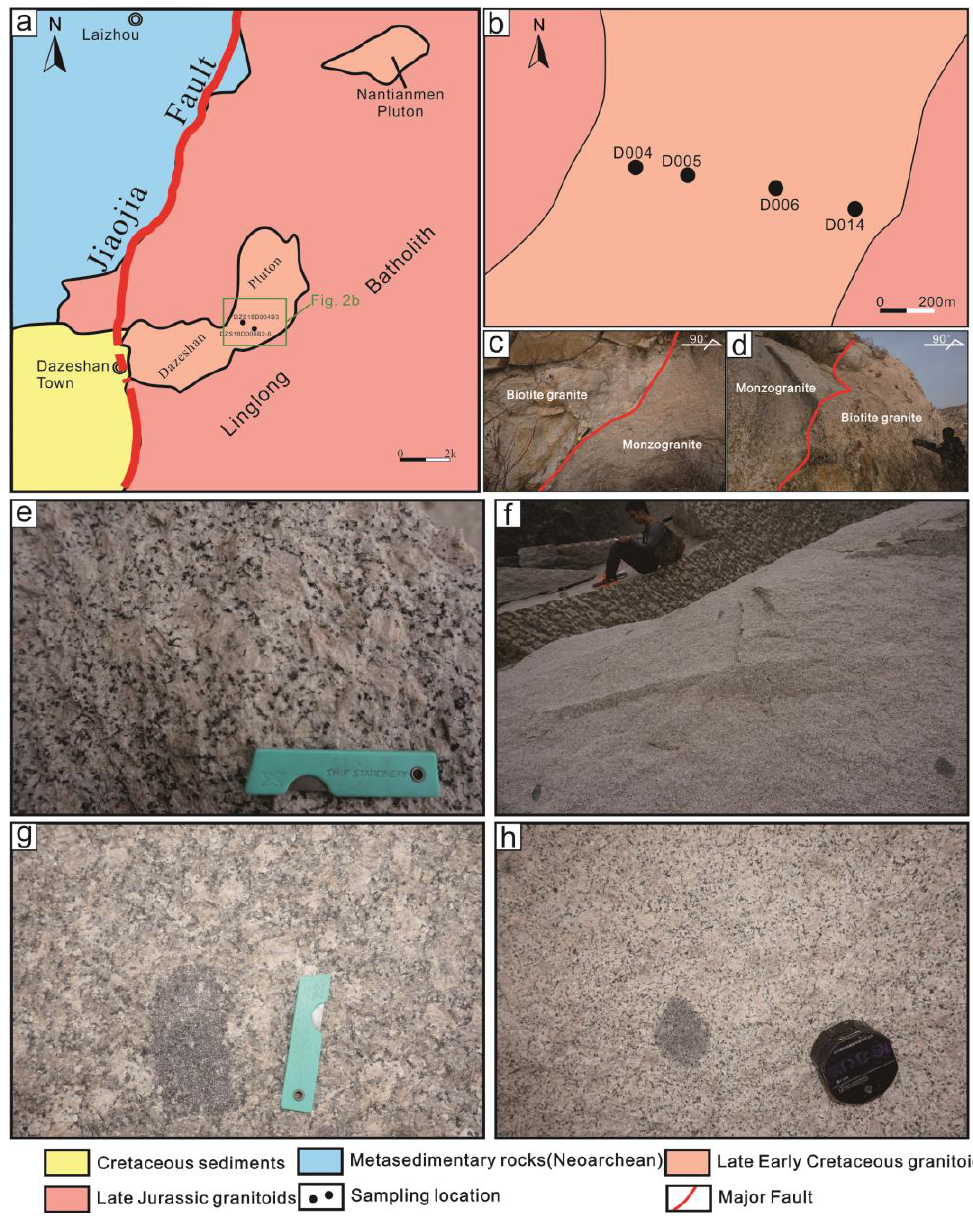
Figure 2. ( a ) Geological map of the Dazeshan pluton, illustrating its location and relation with Linglong batholith. ( b ) Enlarged geological map of Dazeshan granitoids illustrating sample locations. ( c , d ) Contact between fine-grained biotite granite and porphyritic-like monzogranite. ( e ) Porphyritic-like monzogranite with megacrysts of K-feldspar. ( f ) Dark microgranular enclaves in host monzogranites. ( g ) Tabular enclaves with abrupt contacts with their host. ( h ) Oval dark enclaves containing K-feldspar megacrysts.